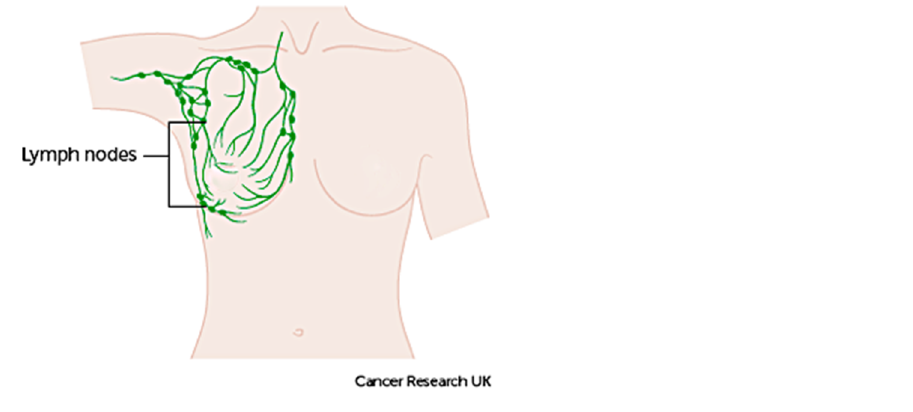
Figure 4. Network of lymph nodes around the breast based on a graphic created by Cancer Research UK [9].